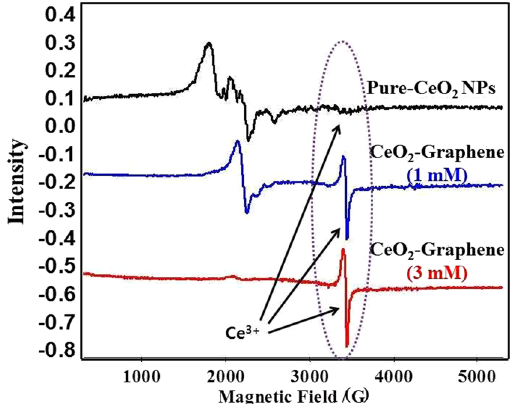
Figure 6. EPR spectra of pure-CeO 2 NPs and 1 mM and 3 mM CeO 2 -Graphene nanostructures at room temperature with a 100 kHz modulation